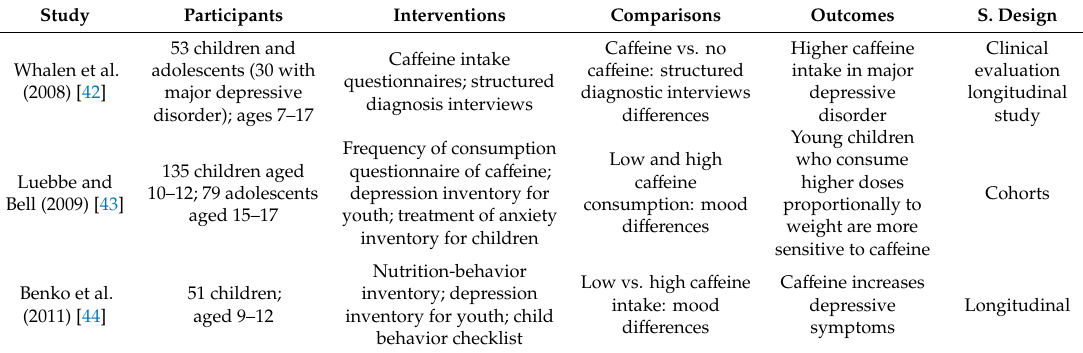
Table 8. Description of analyzed studies on a ff ective states, according to the PICOS 1